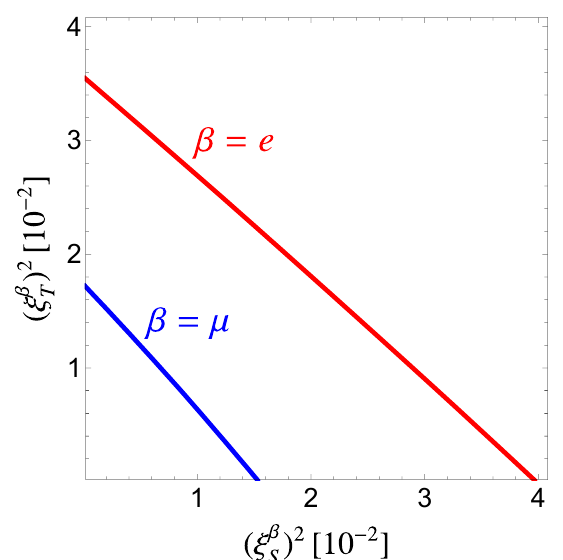
Figure 4. Projected 90% C.L. upper bounds from the future COHERENT experiment with a 610 kg (cid:12)ducial mass of LAr.